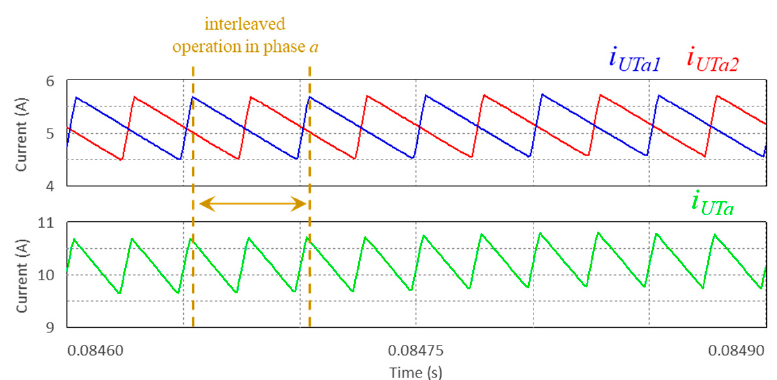
Figure 5. Detail of the interleaved operation in phase a , showing the phase current ( i UTa ), and the currents ( i UTa , i UTb ) on each leg of phase a , permitting to visualize that the currents i UTa and i UTb are in phase opposition, and that the current i UT is the sum of the currents i UTa and i UTb .